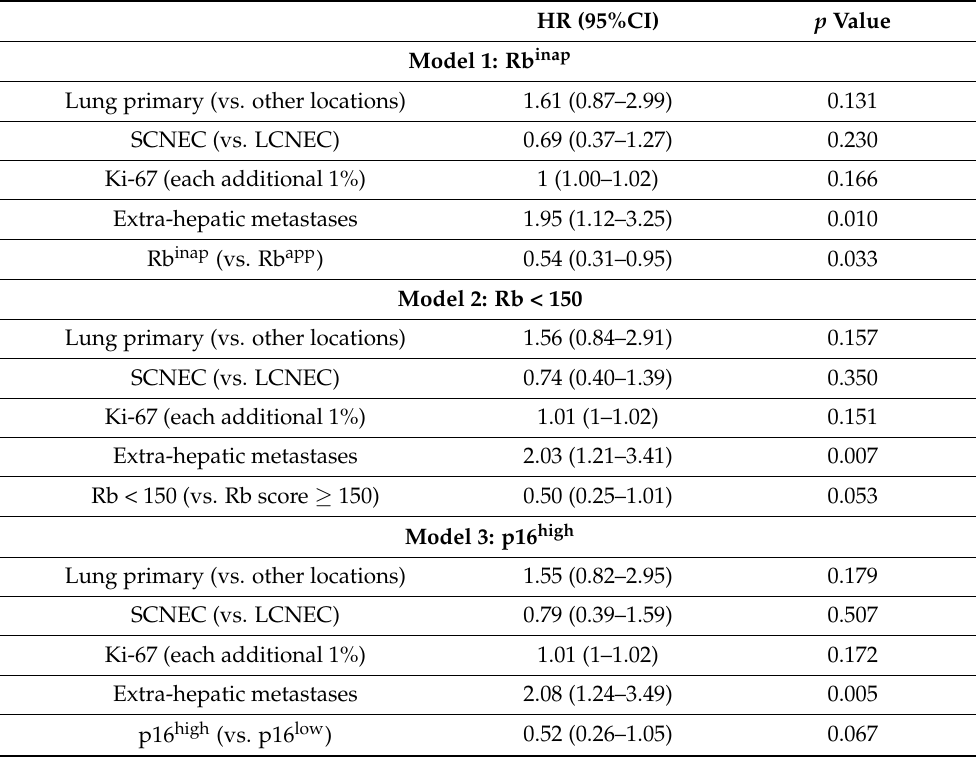
Table 4. Multivariate analysis of factors associated with the risk of death among patients with